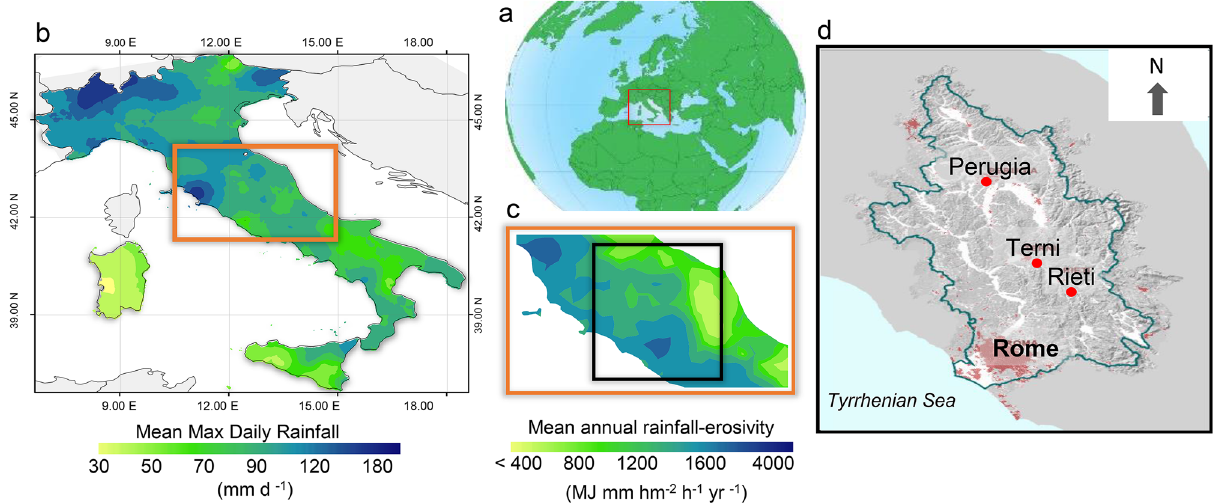
Figure 2. Environmental setting and rainfall patterns. ( a ) Framing of the central Mediterranean sector (red box), obtained from Collection of Free Vector Earth (http:// clipa rt- libra ry. com/ free- vector- earth. html); ( b ) Spatial pattern of mean maximum daily rainfall (inverse distance weighting interpolation) in the period 1994–2003 (orange box indicates central Italy); ( c ) Downscaled (co-kriging interpolation) mean annual rainfall erosivity in central Italy (orange box) and across the Tiber River Basin (black box) in the 2003–2012 period (arranged from the Global Rainfall Erosivity Database—https:// esdac. jrc. ec. europa. eu/ themes/ global- rainf all- erosi vity—based on the European Soil Data Centre—https:// esdac. jrc. ec. europa. eu); ( d ) Boundary of the Tiber River Basin with indication of the main cities. In ( c ), the erosivity values roughly cover the range from the third (200–400 MJ mm hm −2 h −1 yr −1 ) and the eight (3100–5200 MJ mm hm −2 h −1 yr −1 ) of 10 erosivity classes from Panagos et al. 129 . Graphs ( b ) and ( c ) are derivative maps generated using the Geostatistical Analyst extension